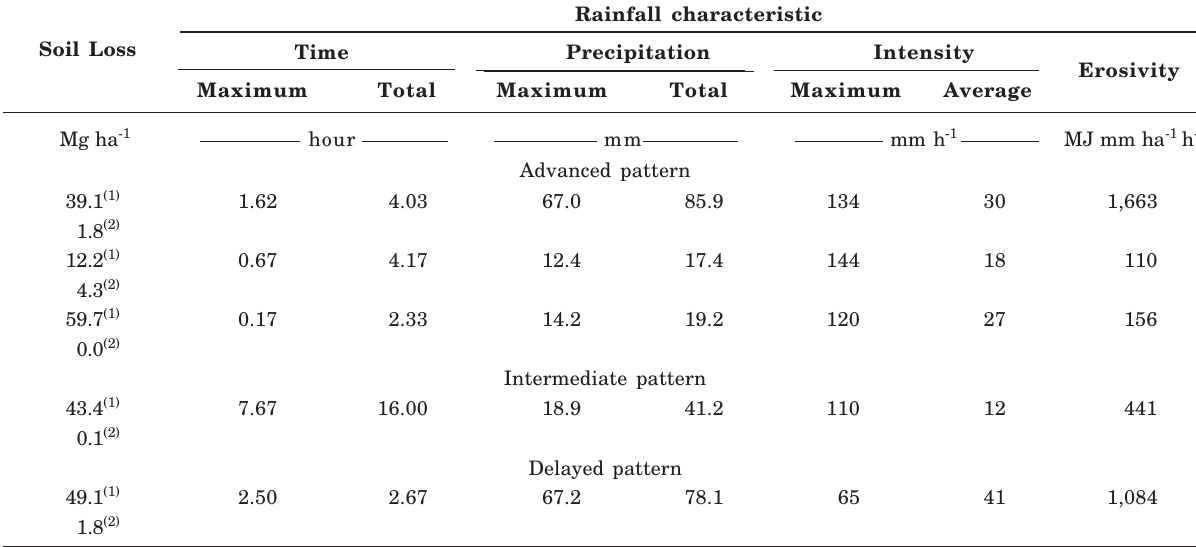
(1) Data of a typic dystrophic Tb Haplic Cambisol (CXbd); (2) Data of a typic dystrophic Red Latosol